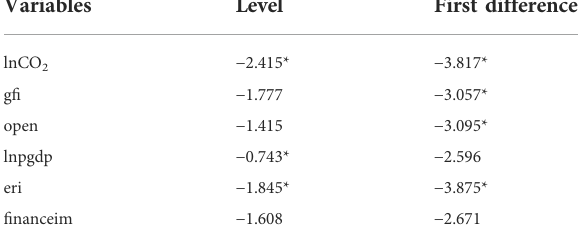
TABLE 5 Pedroni test for cointegration.